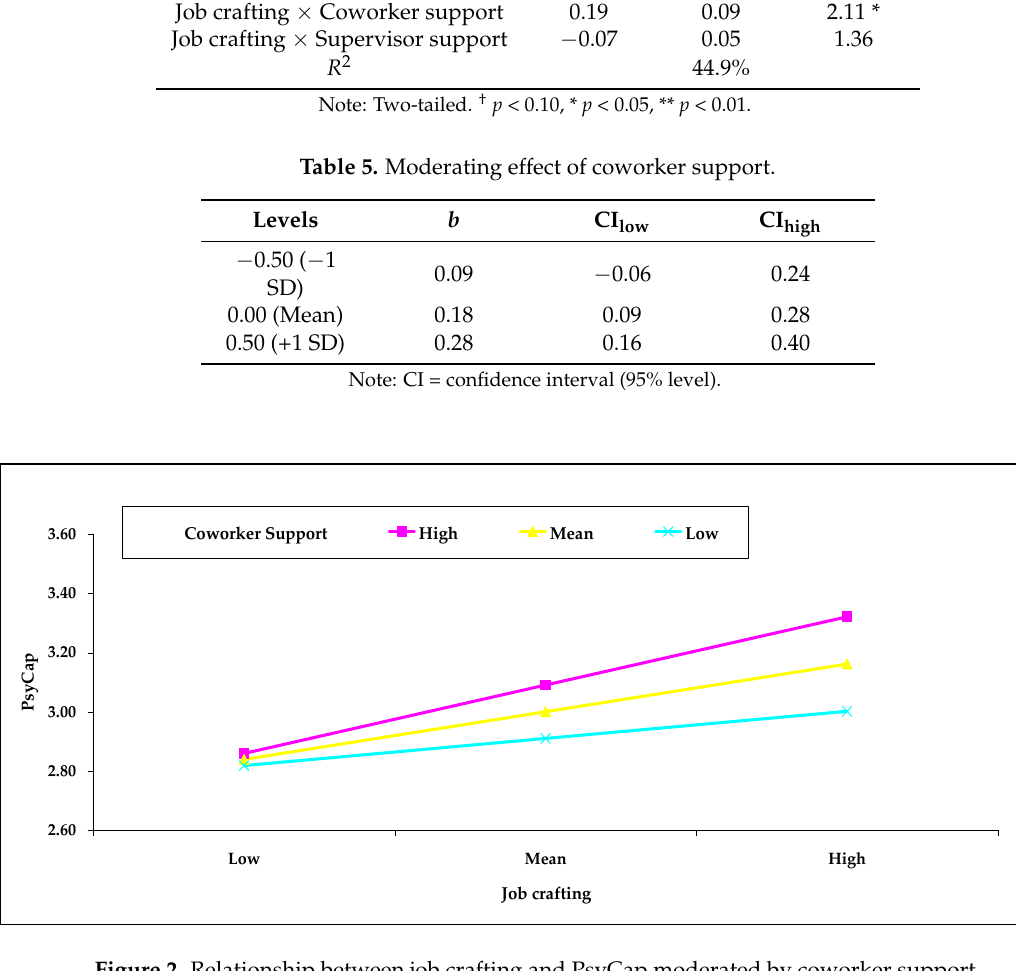
Figure 2. Relationship between job crafting and PsyCap moderated by coworker support.